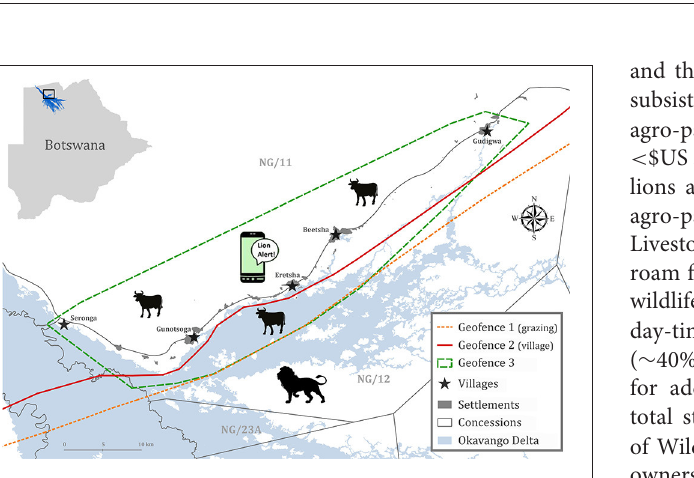
FIGURE 2 | Design of the lion alert system during the pilot study (May 2016–May 2018) showing the placement of virtual geofences across the study area in the northern Okavango Delta, Botswana. Geofences 1 and 2 were programmed into lion GPS tracking units deployed until end of 2017, Geofence 3 into units deployed from January 2018